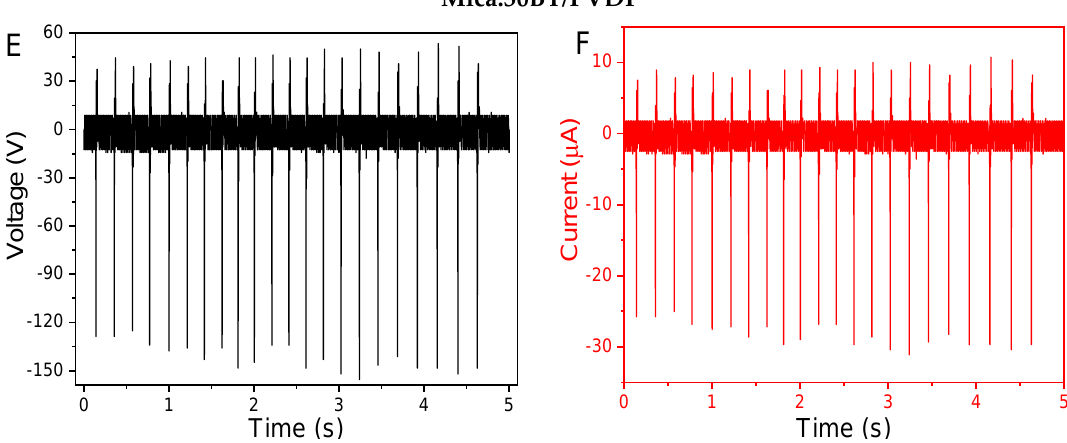
Figure 2. Open-circuit voltage (left) and the short-circuit current (right) measurements for different pairs of polymers. The pairs PA66:PP ( A , B ), PA66:SEBS ( C , D ) and Mica:30BT/PVDF ( E , F ), measured with a R L = 5 MΩ under constant force (10 N) in contact-separation mode.